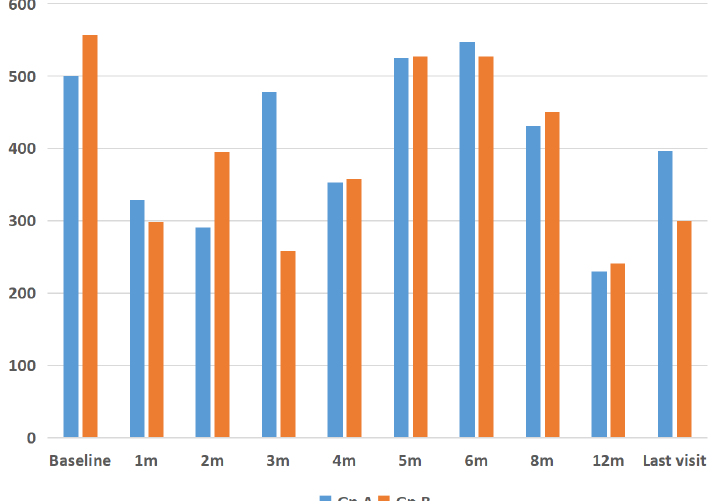
Figure 3: Comparison of changes in central macular thickness (CMT) after Ozurdex ® injection for refractory diabetic macular edema in eyes with single (group A) and multiple (group B) injections